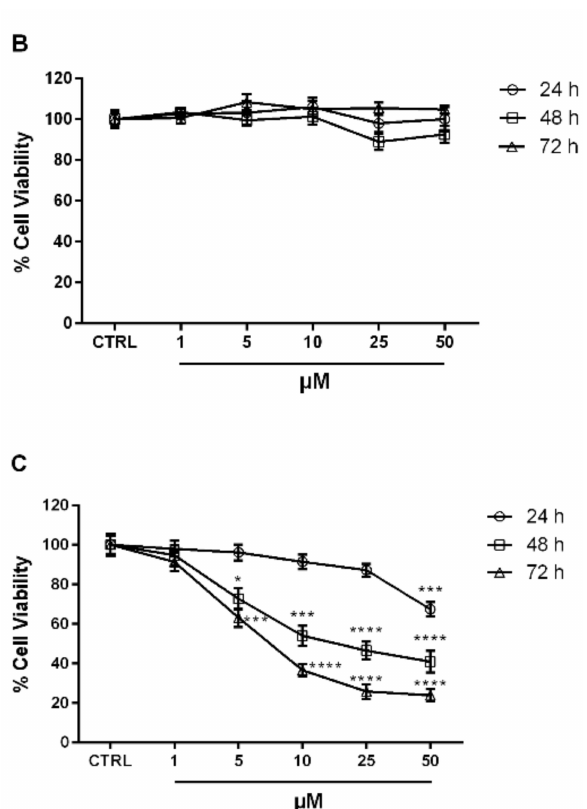
Figure 4. Compounds 1a ( A ) and 3 ( C ) exerted antiproliferative effect on SH-SY5Y cells exposed to increasing concentration of synthesized compounds for 24, 48, and 72 h. No antiproliferative effect was observed for compound 2a ( B ). Each value is the mean ± S.E.M. of three experiments performed eight times. **** p < 0.0001, *** p < 0.001, ** p < 0.01, * p < 0.05 vs.